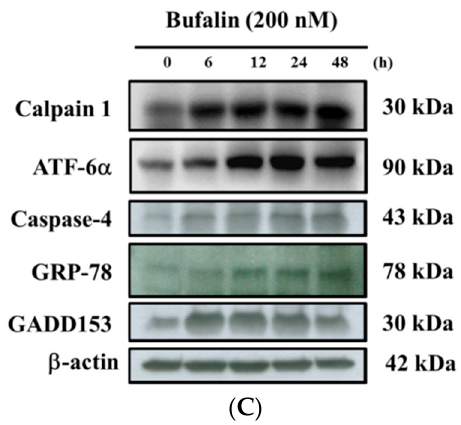
Figure 6. Bufalin affects apoptosis associated protein expression in U-2 OS cells. Cells were treated with 200 nM of bufalin for 0, 6, 12, 24, and 48 h, and then the total proteins were quantitated and the apoptosis associated proteins were measured by Western blotting, as described in Materials and Methods. ( A ) Bcl-2, Bcl-xl, Bax, cytochrome c, AIF and Endo G; ( B ): caspase-8, -9 and -3, Fas, Fas-L, and cleaved PARP (poly (ADP-ribose) polymerase); ( C ): Calpain 1, ATF-6 α , Caspase-4, GRP-78 and GADD153. 2.7. Bufalin Altered the Translocation of Apoptotic Associated Proteins in U-2 OS Cells In order to further confirm that bufalin affects the translocation of Endo G and that cytochrome c and AIF are involved in apoptosis of U-2 OS cells, cells were incubated with or without 200 nM of